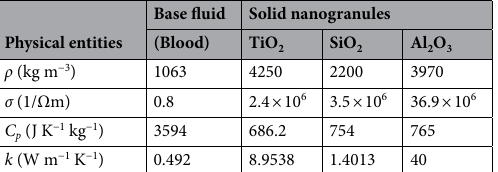
Table 1. Thermophysical features of the blood based ternary nanofluid 26–28 .